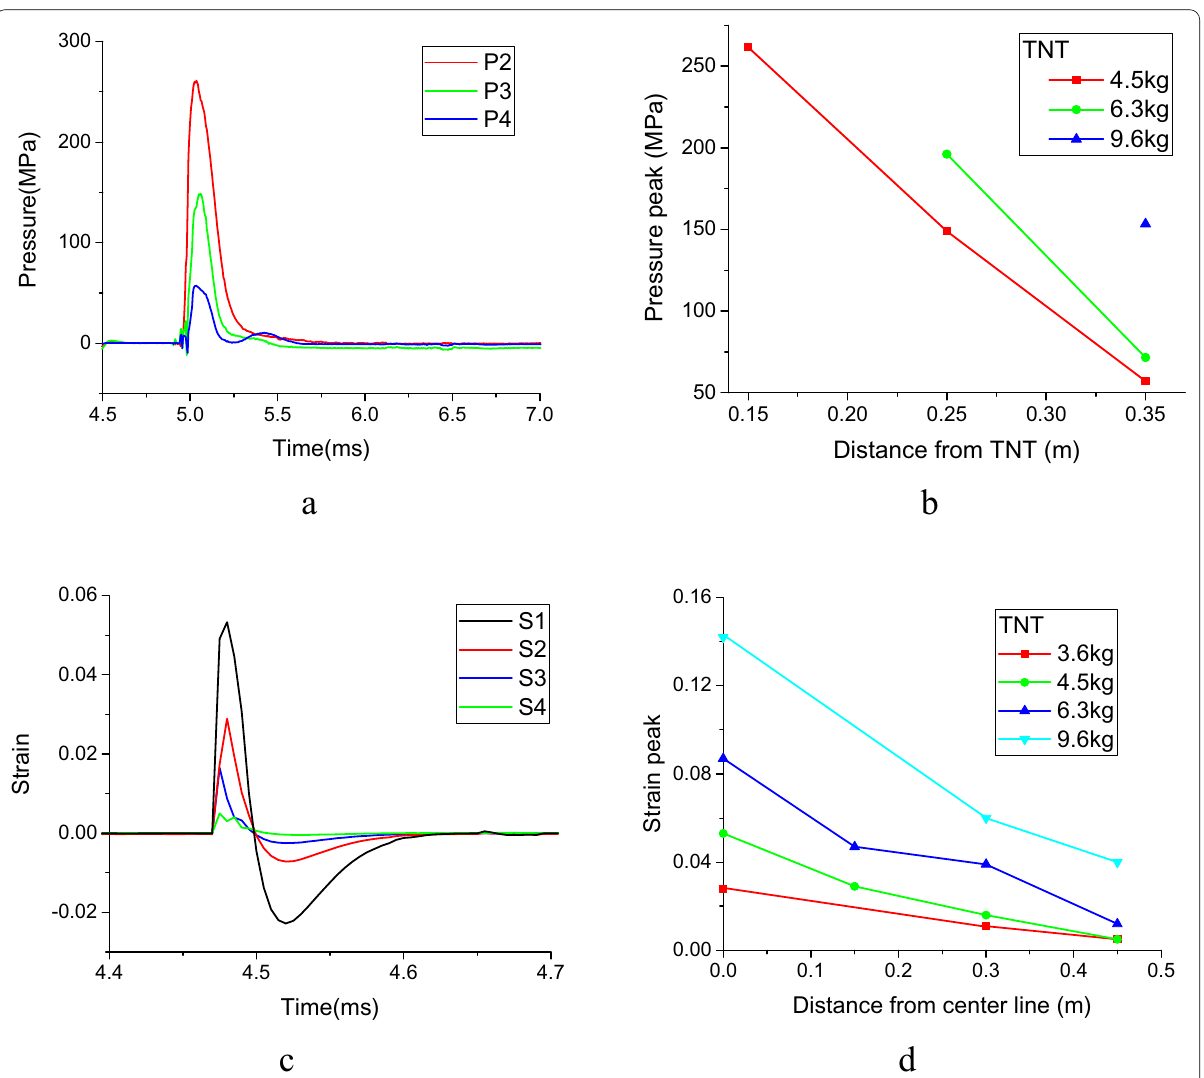
Fig. 9 Test results of FC05: a pressure time history curve under 4.5 kg explosion, b pressure peak, c strain time history curve under 4.5 kg explosion and d strain peak.